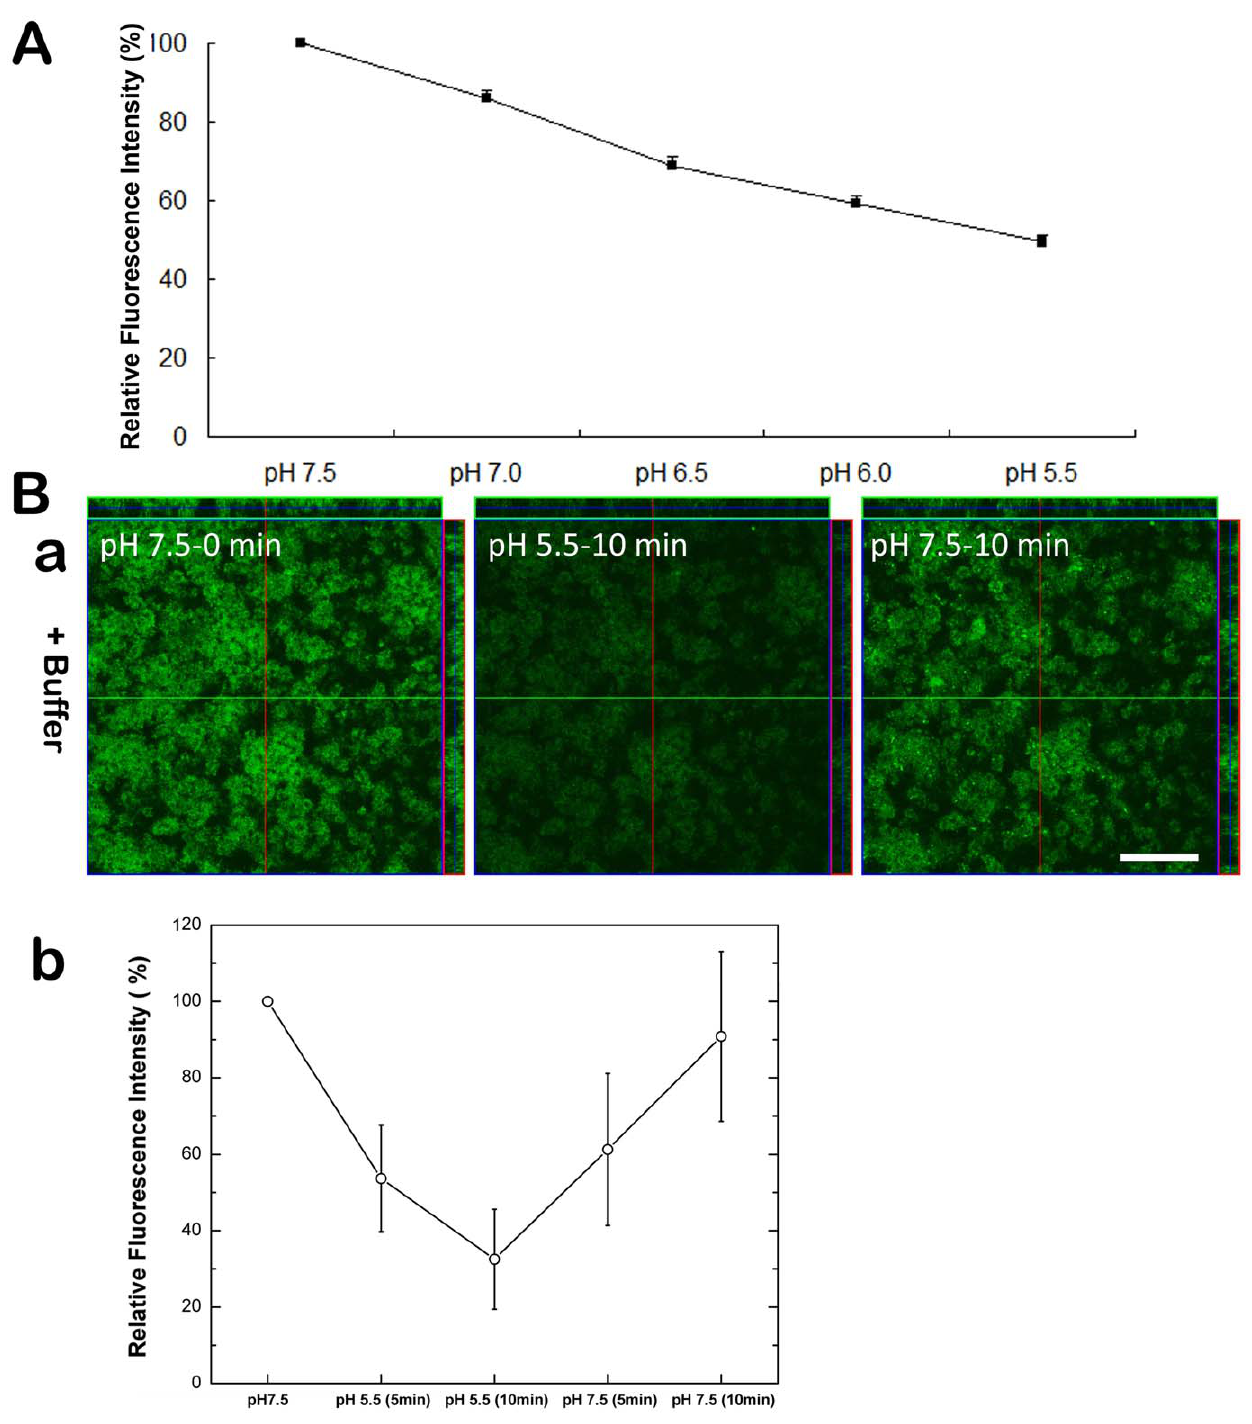
Figure 2. pH-responsivity of surface-expressed pHluorin in S.mutans . (A) Fluorescence signal intensity of the pHluorin-SpaP fusion protein in S. mutans strain O87 at different pH values. Planktonic cells of strain O87 were adjusted to the indicated pH values. The ratio was calculated as the amount of pHluorin signal at each pH value vs. the initial signal at pH 7.5. The plots show the average of triplicate samples, and the error bars correspond to the standard deviations. (B) Time-course of surface-expressed pHluorin fluorescence signal in S. mutans biofilms at different pH values. CLSM analysis of surface-expressed pHluorin signals in S. mutans O87 biofilms is shown in (a). The fluorescence of biofilms was monitored at pH 7.5 (left), shifted to pH 5.5 for 10 min (middle) followed by a shift back to pH 7.5 for 10 min (right). Quantification of pHluorin signals in biofilms at different pH is shown in (b). The ratio was calculated as the amount of pHluorin signal at each time point vs. initial amount (0 min). The plots represent the average of three duplicate tests.